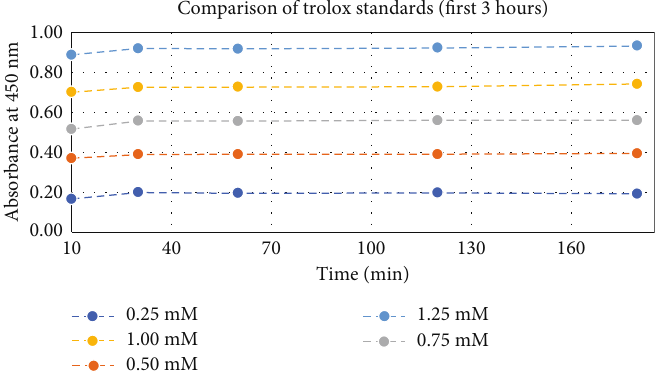
Figure 3: Stability of Trolox working standards over